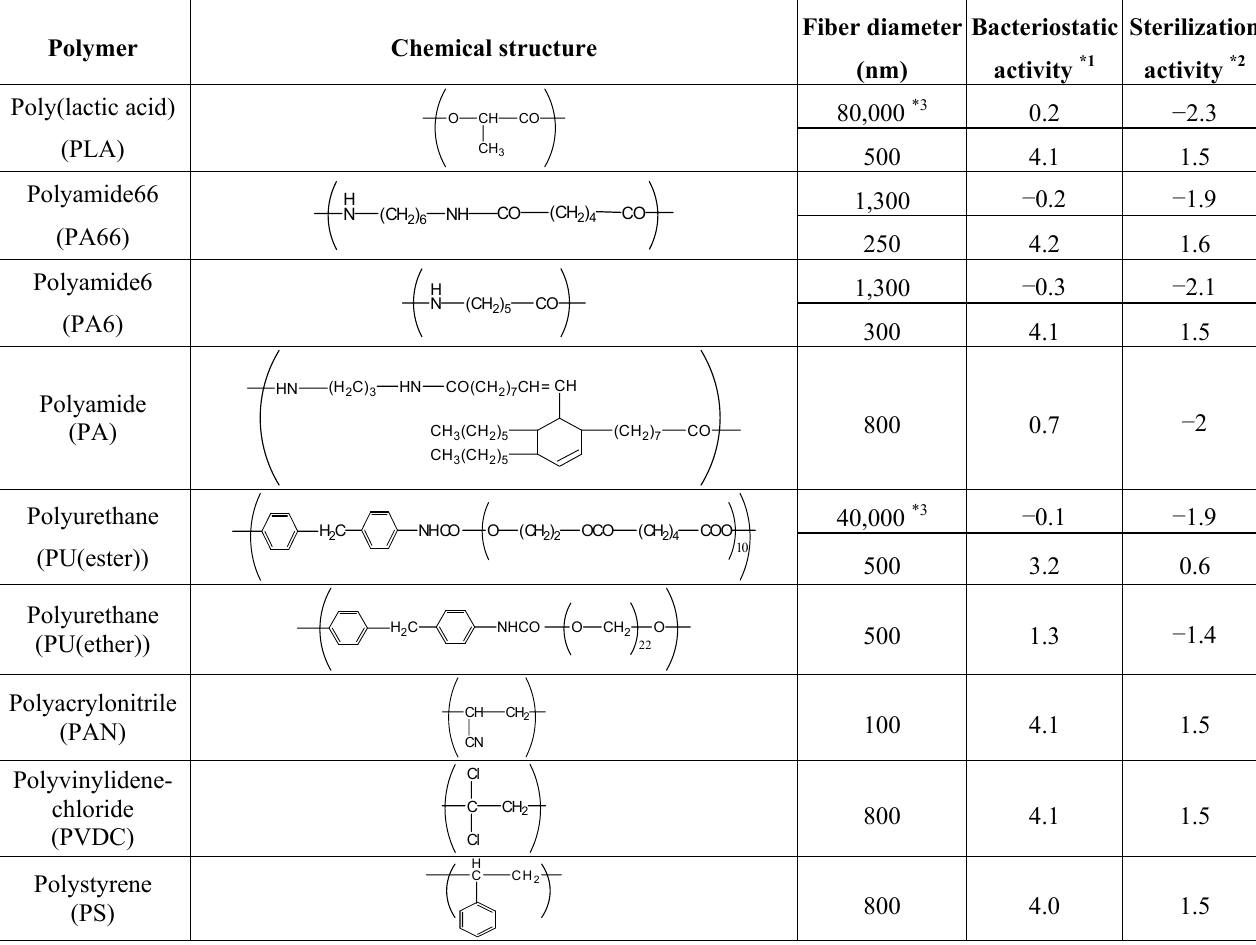
4. Antimicrobial activity of electrospun commodity polymer nanofibrous membranes (Adapted from